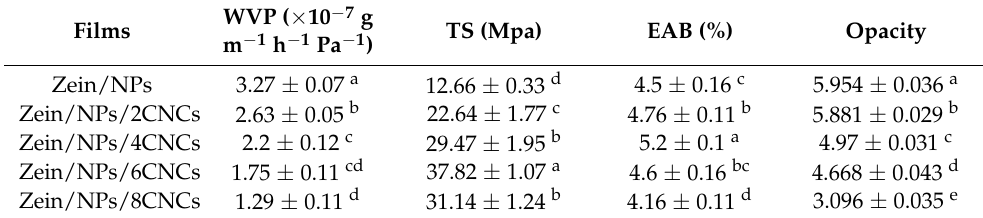
Table 2. WVP, TS and EAB of zein